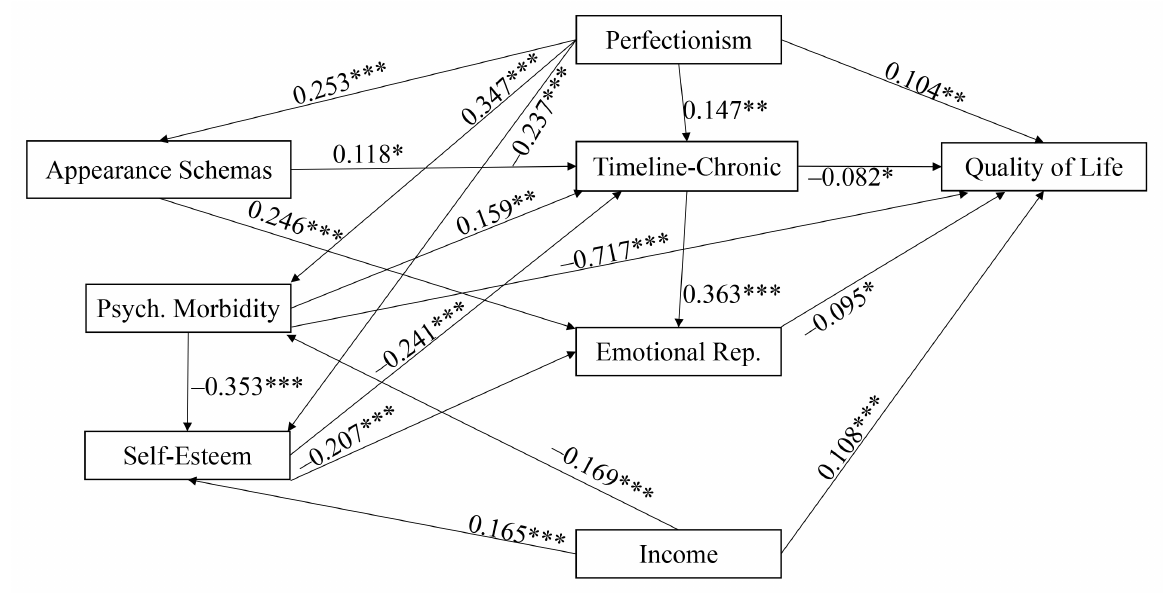
Fig. 3. Results of the final path analysis taking in account Wilson and Cleary’s (1995) model. * p ≤ 0.05; ** p ≤ 0.01; *** p ≤